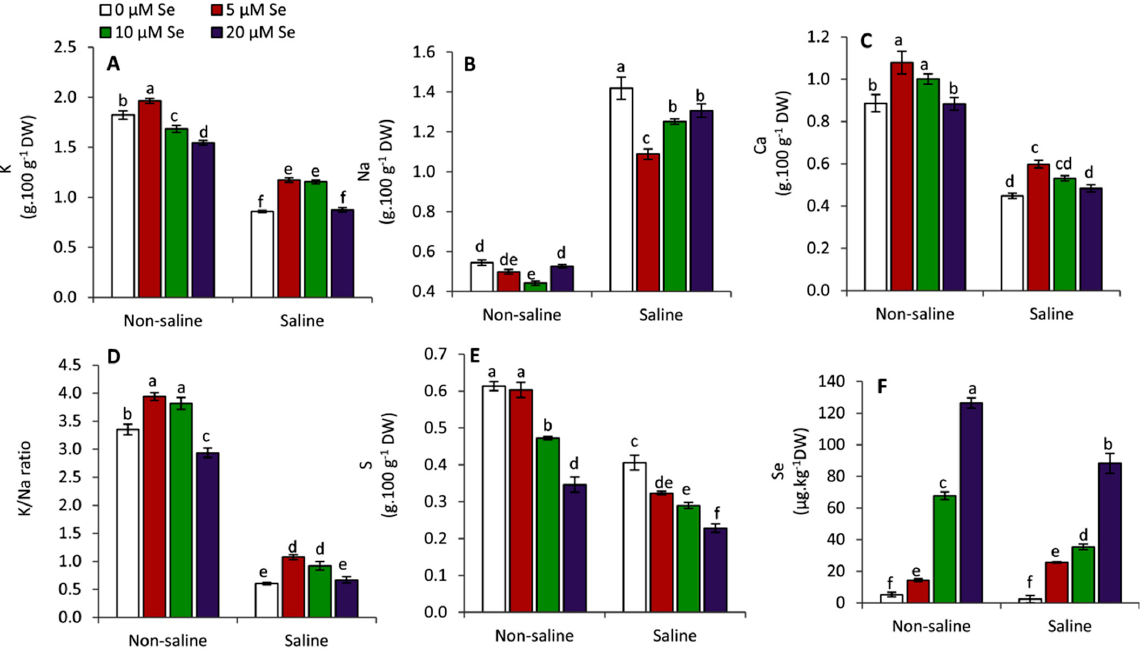
Figure 6. Effect of Se supplementation at 5, 10 and 20 µM on the leaf content of K ( A ), Na ( B ), Ca ( C ), K/Na ratio ( D ), S ( E ) and Se ( F ) of non-stressed and salt-stressed (50 mM NaCl) snap bean seedlings (28 days after sowing). The results are expressed as mean values of three measurements ± SE using Duncan’s multiple range test ( p = 0.05). Different letters indicate significant differences among the treatments.